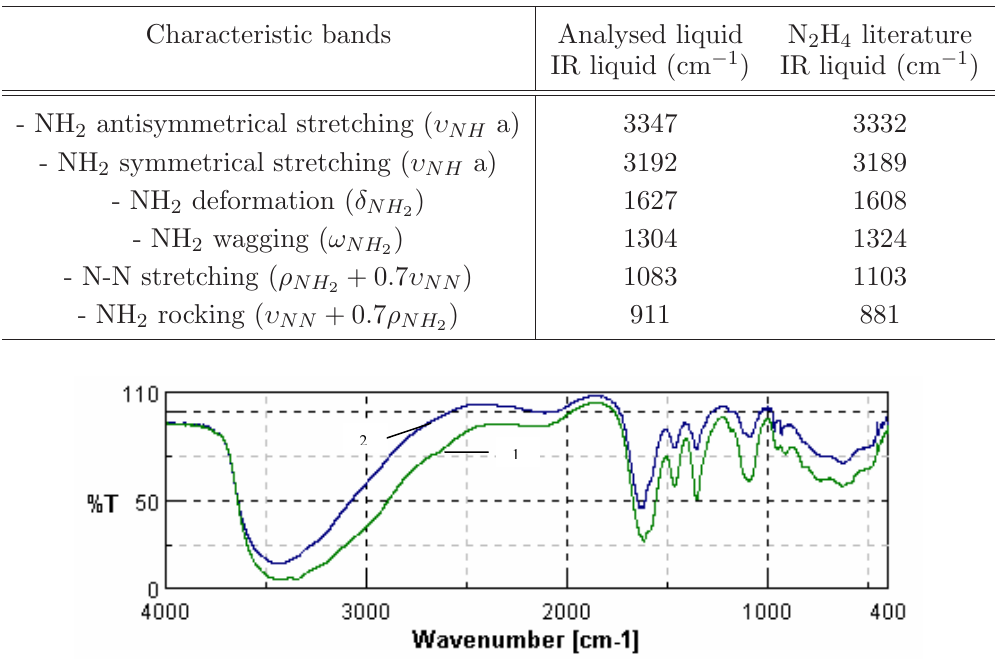
Fig. 3 Superposition of the 98% N 2 H 4 (1) and of the analyzed liquid (2)